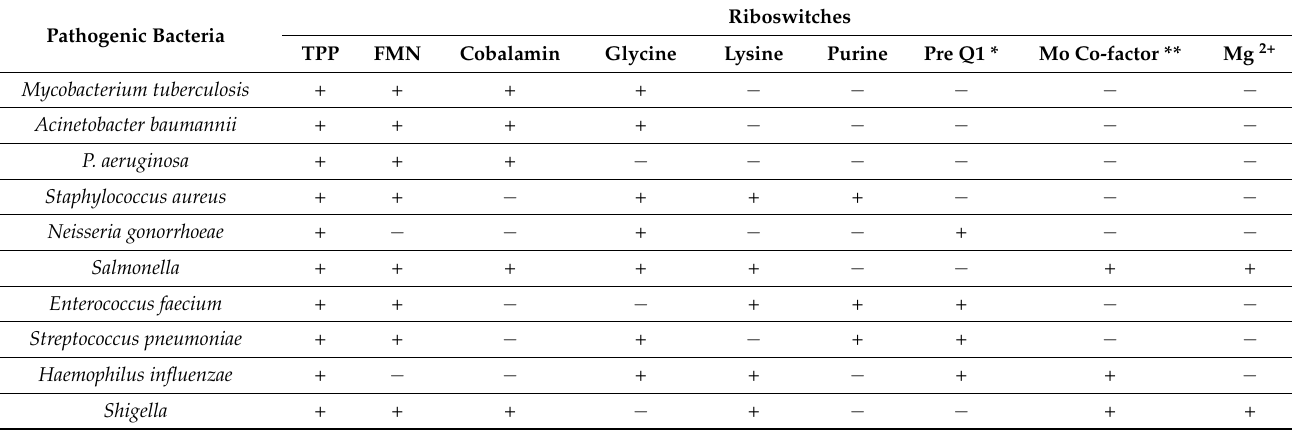
Table 2. Riboswitches found in human bacterial